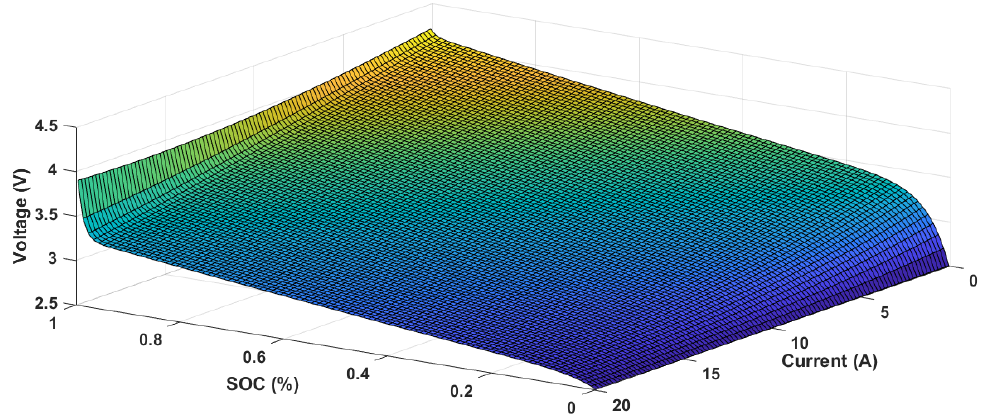
Figure 23. Data fitted by the third-degree exponential function of for SoH =